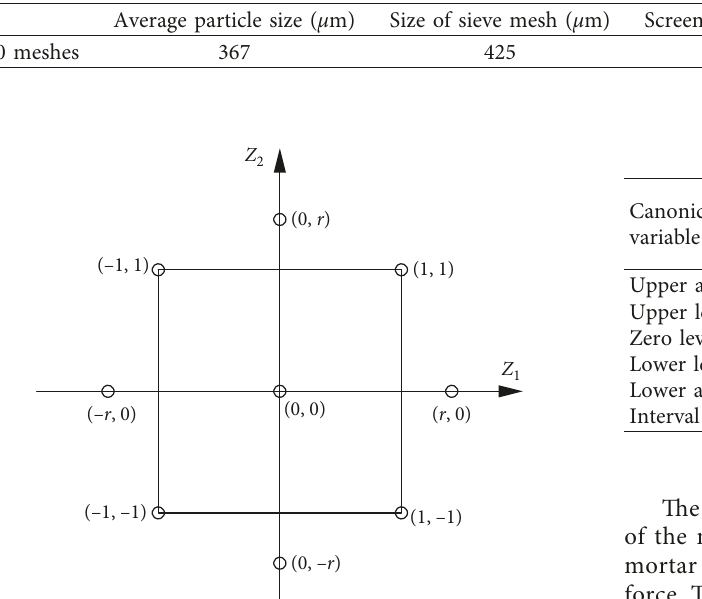
Table 4: Technical data of rubber powder.